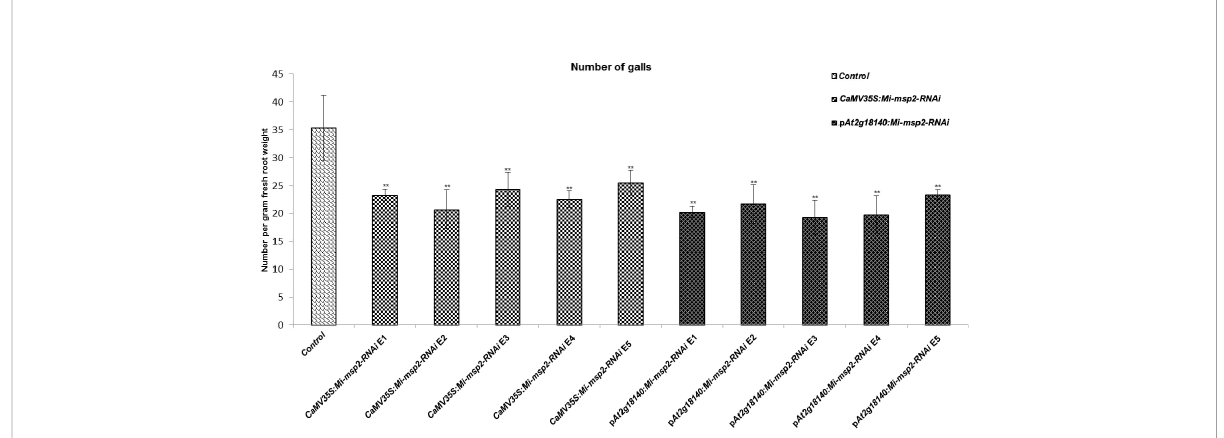
FIGURE 2 Five independent RNAi lines each for constructs CaMV35S::Mi-msp2-RNAi and p At2g18140::Mi-msp2-RNAi exhibit a reduction in infection represented by a reduction in the number of galls compared to the control line evaluated for M. incognita infection. Each bar represents the mean ± SE. Double asterisks indicate statistically signi fi cant differences by one-way ANOVA and Tukey ’ s test (p ≤